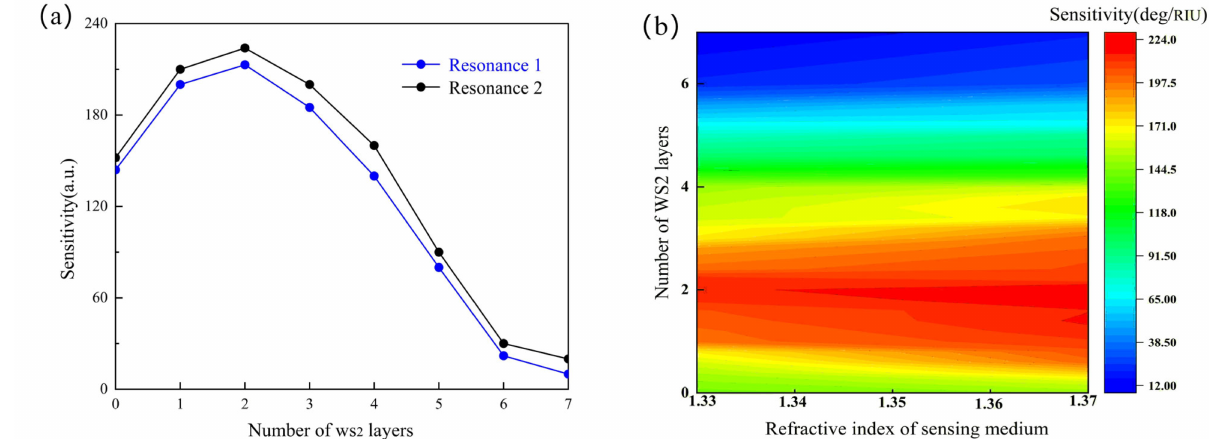
Figure 6. ( a ) Trends in sensor sensitivity when stacking the different thicknesses of WS 2 ; ( b ) sensitivity distribution of the sensors with different WS 2 structural layers during the gradual increase in the RI of the detection medium (1.330–1.370).